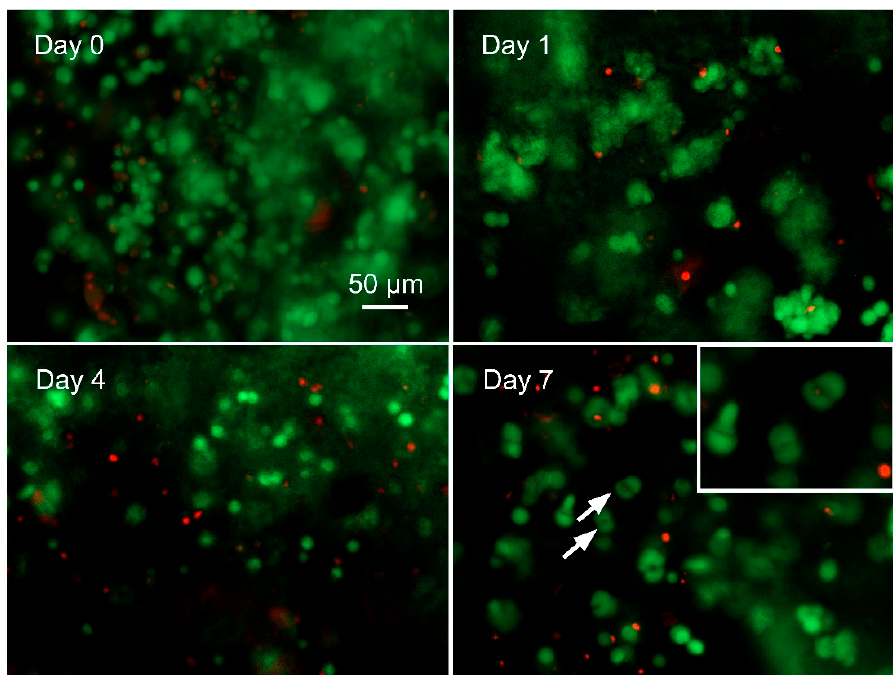
Figure 5. Viability of printed human nasal chondrocytes within cylinders (7 mm diameter × 2mm in height, wall thickness 1.5 mm) printed with CANA bioink instantly after print (day 0), on day 1, day 4, and day 7, as determined by live / dead assay. All experiments were carried out in triplicate. (n = 3). The inset shows a higher magnification of the area pointed out by white arrows and identifies chondrocytes with a typical morphological profile of cells in the process of undergoing cell division (mitosis), indicating that the CANA bioinks are permissive to proliferation of human primary cells.